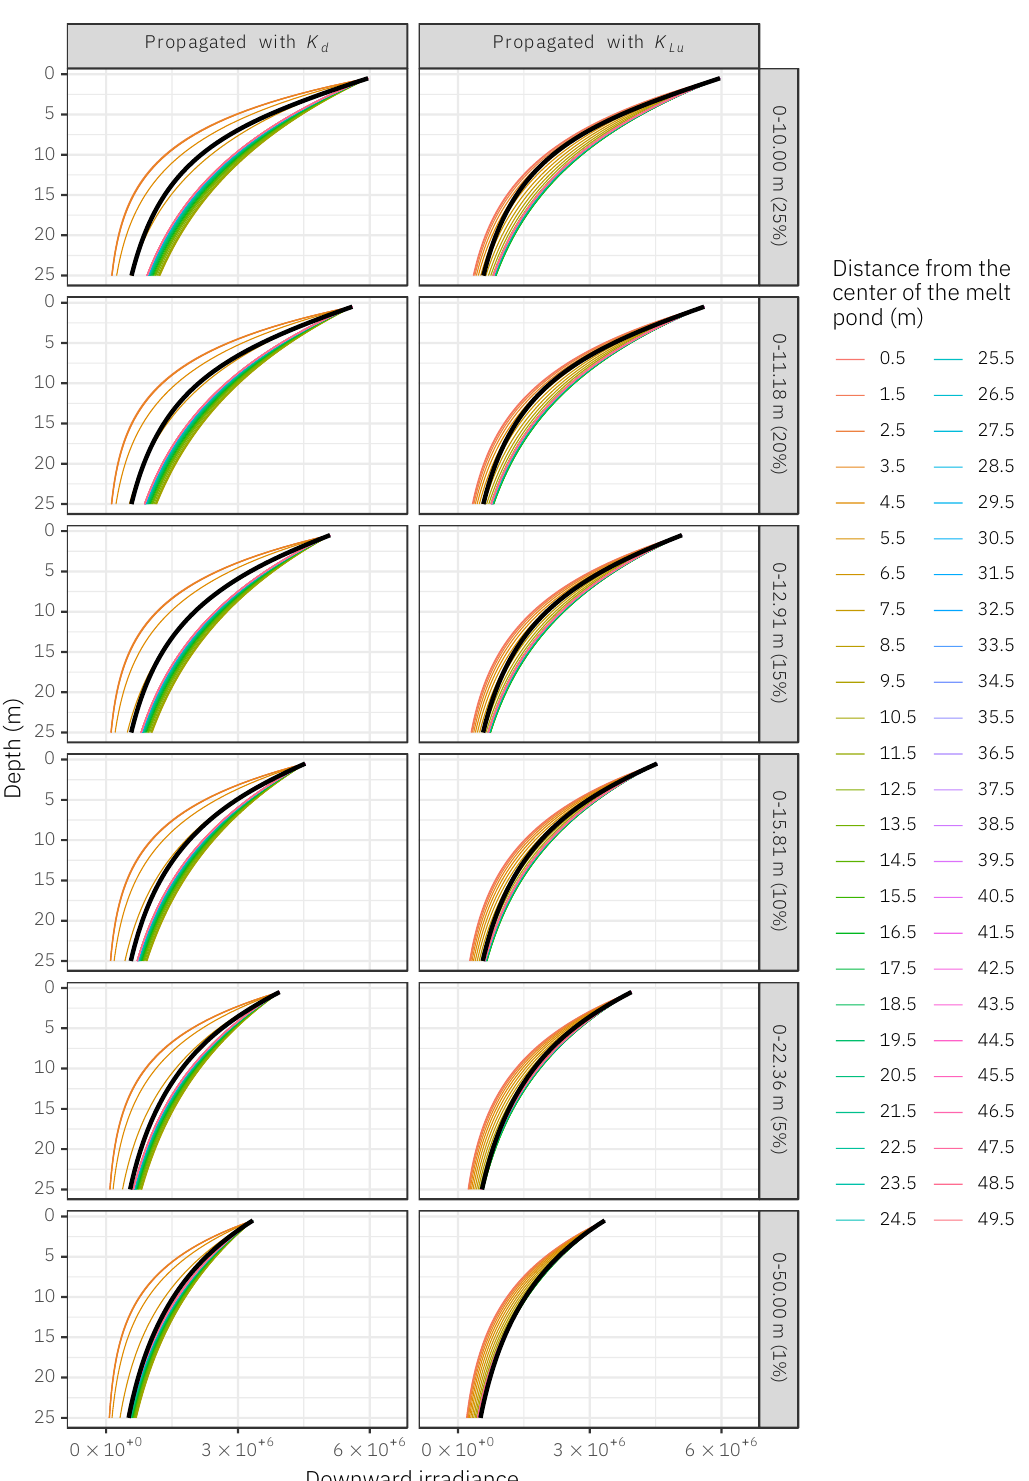
Figure 10. Reference downward irradiance profiles (thick black lines, in relative units) and propagated irradiance through the water column (coloured lines, in relative units) using local values of K d and K Lu (see Figure 8). Light was propagated using the surface reference downward irradiance.